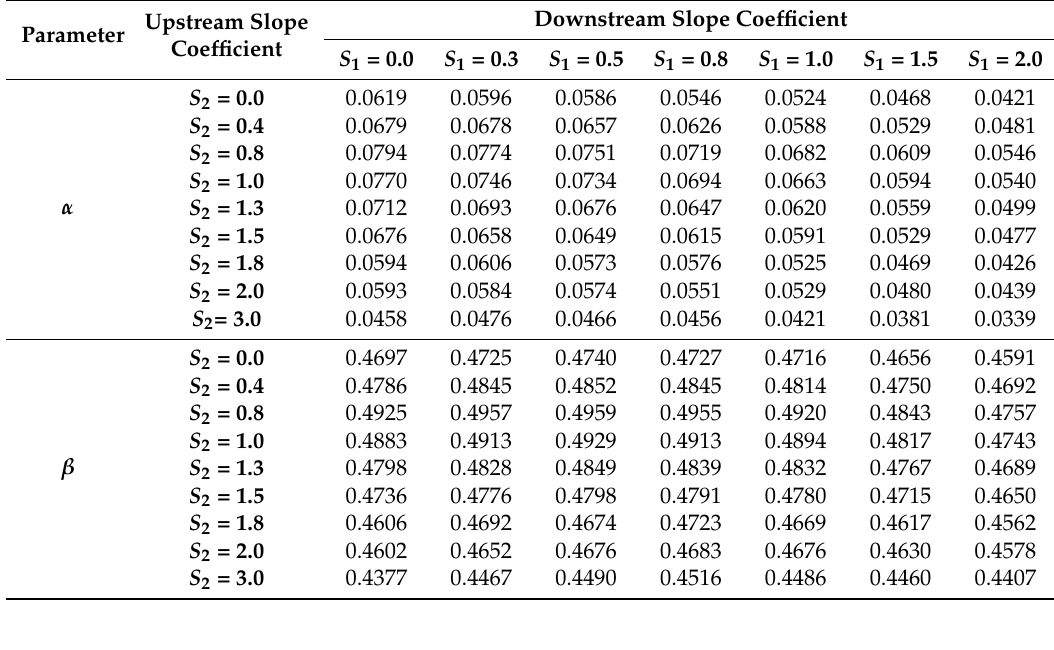
Table 5. Values of α and β in different combinations of upstream and downstream slope coefficients.